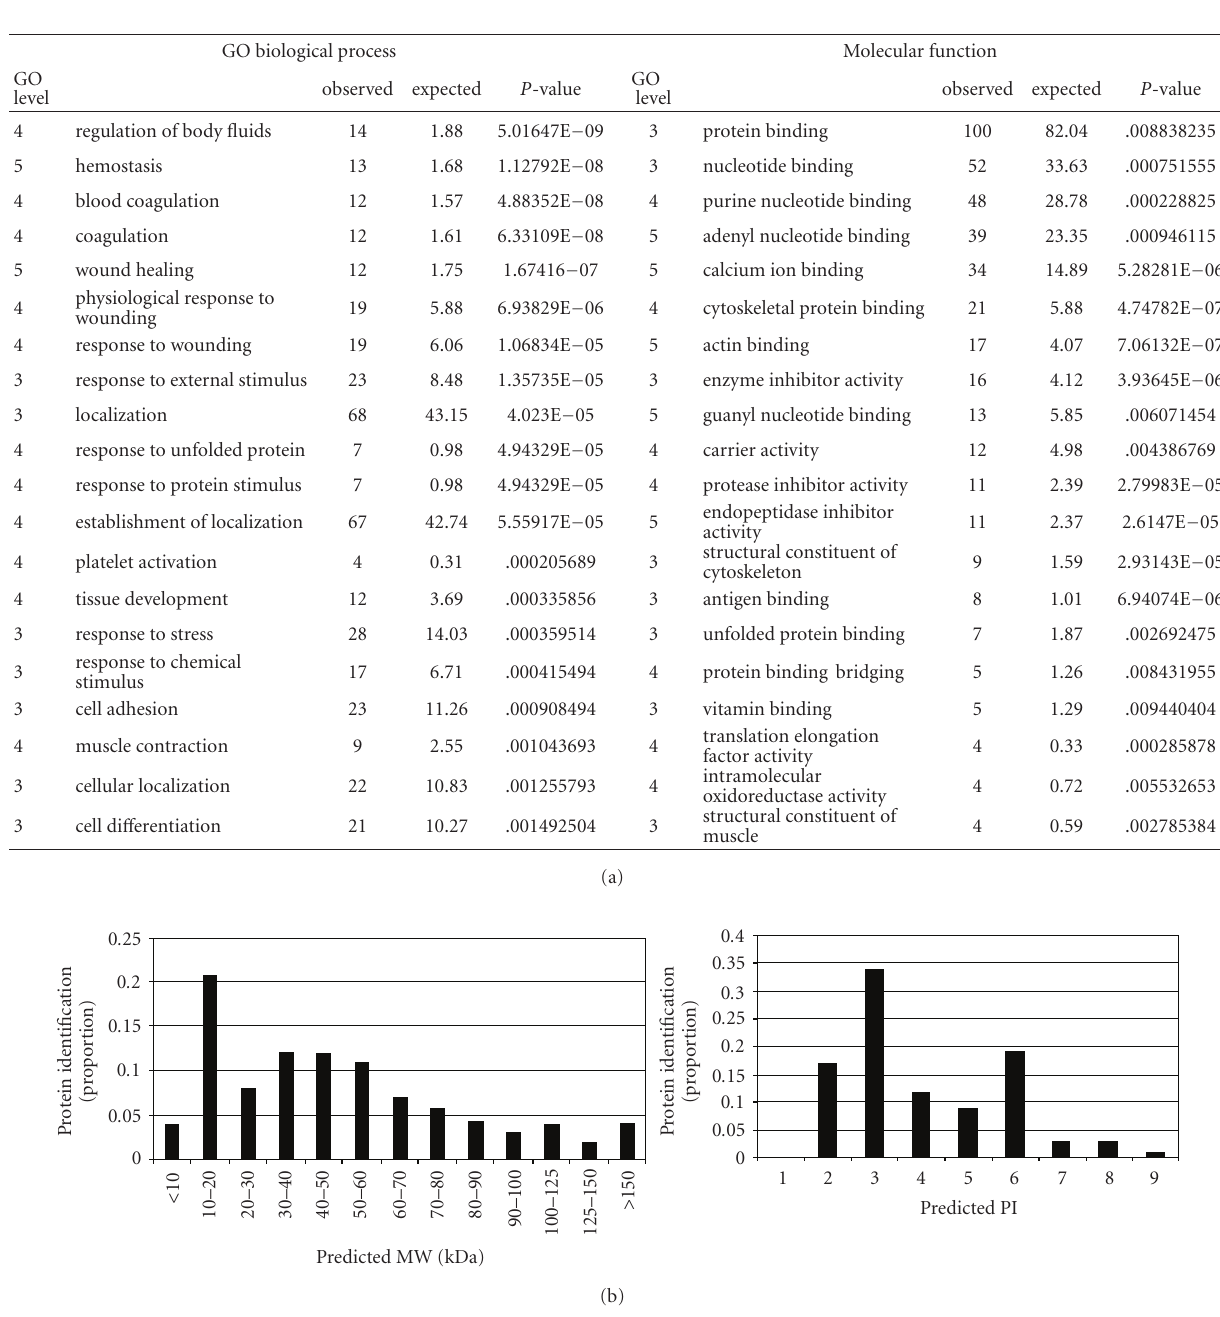
Figure 4: Bioinformatic analysis of the fractionated platelet releasate. (a) Gene ontology (GO) terms found to be significantly enriched in the experimental dataset of platelet releasate proteins (“Observed”) in comparison to a reference dataset of human proteins (“Expected”) along with the GO level associated with each individual ontological term. (b) The range of molecular weights (left panel) and isoelectric points (right panel) of proteins identified in this